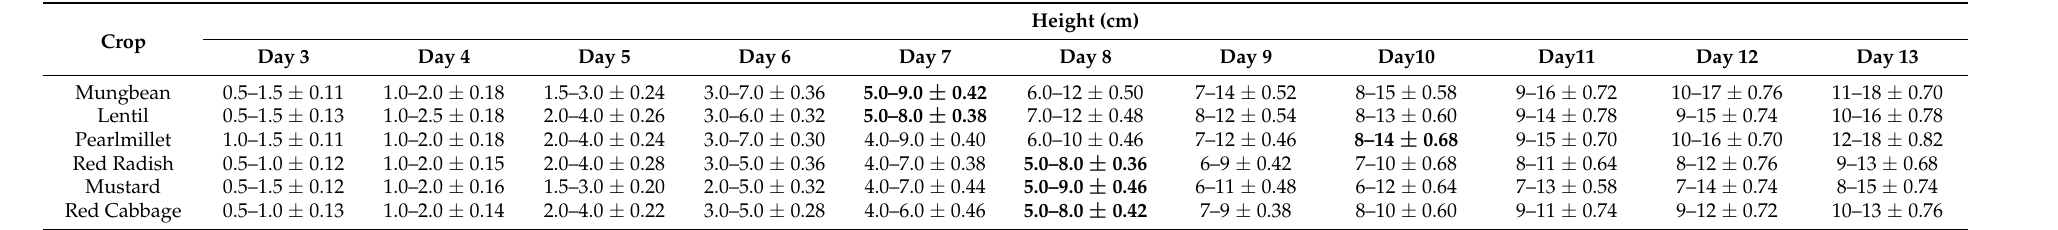
Table 5. Height of different microgreens species on different days after